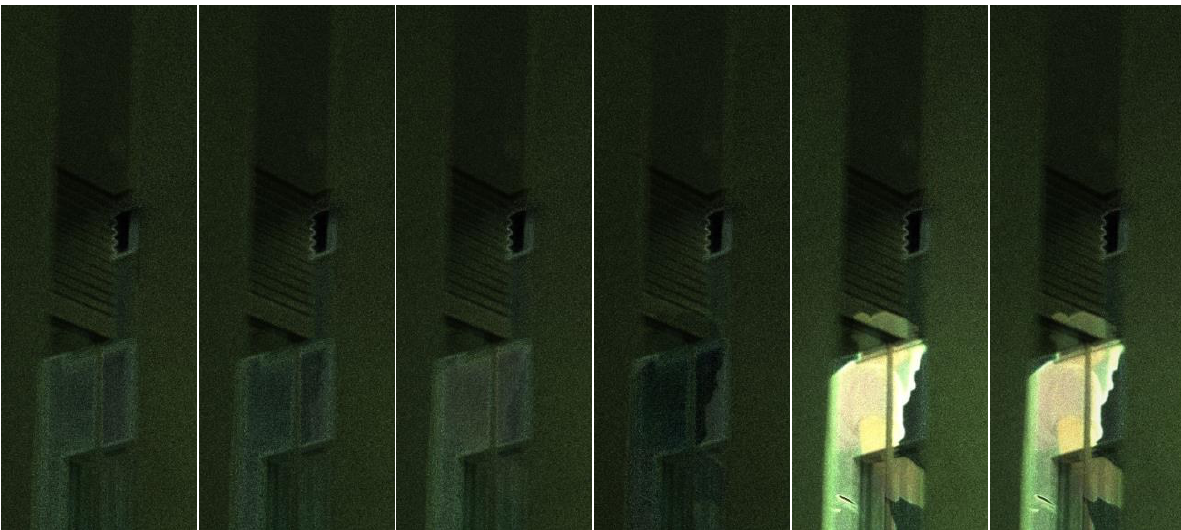
Figure 8 | Example key frames from Site , showing the Gibbs oscillation as a person enters the picture, with second and forth image undershooting to dark, third and fifth overshooting to